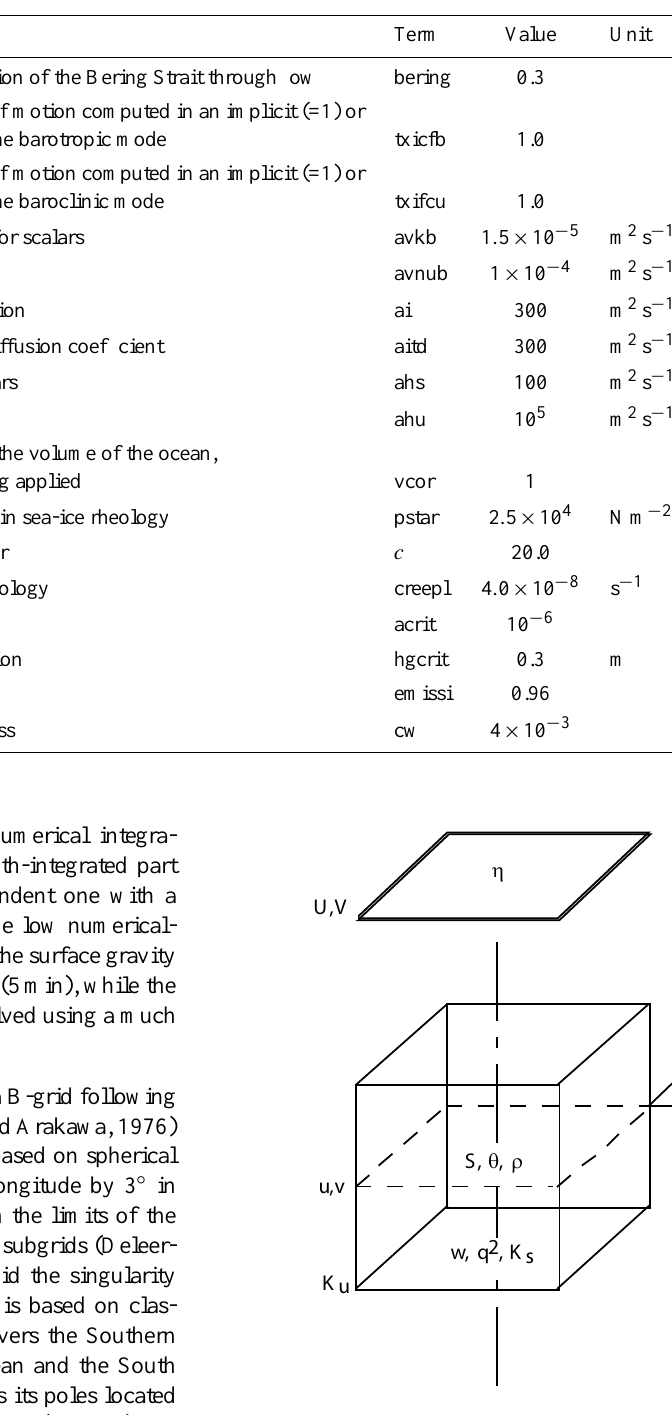
Fig. 3. Location of the various variables on the grid of CLIO. U , V are the two components of the barotropic velocity, η the surface elevation, u , v , and w the three components of the velocity, S the salinity, θ the potential temperature, q 2 (two times) the turbulent kinetic energy, and K s and K u the vertical diffusion and vertical viscosity.